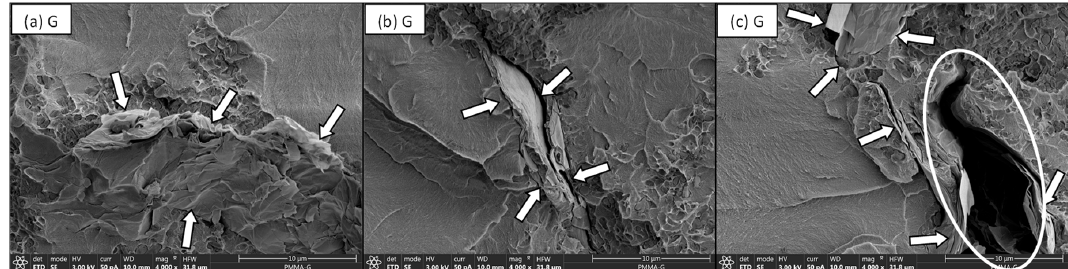
Figure 6. SEM micrographs of bone cement with G, at 4000× magnification ( a – c ) showing regions with a relatively poor interaction between the G sheets and the PMMA matrix.